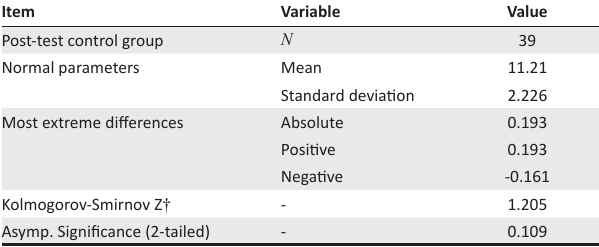
TABLE 5: One-Sample Kolmogorov-Smirnov Test. Item